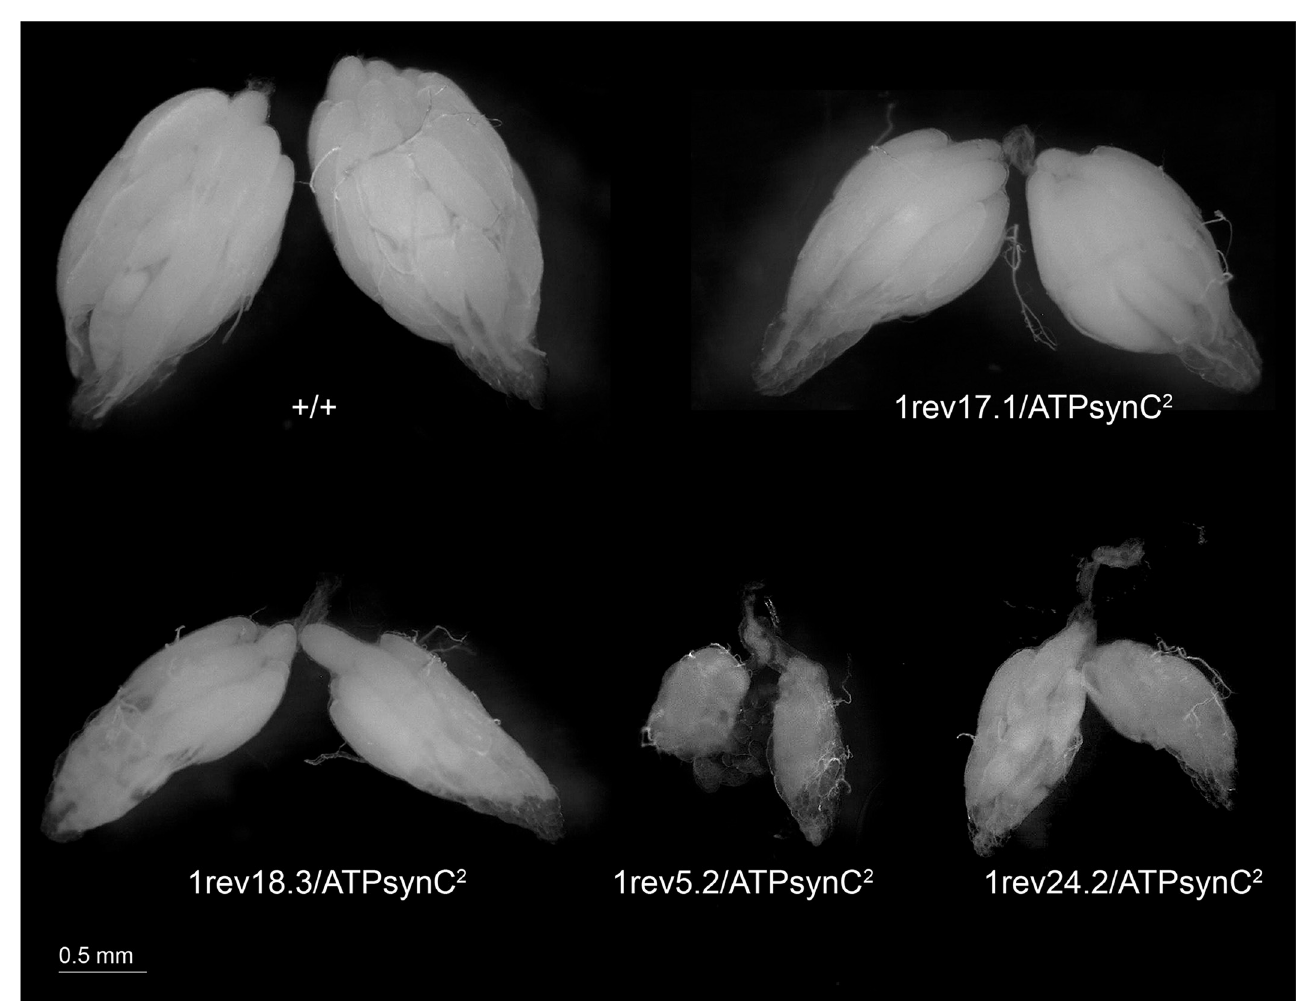
Fig 5. Aberrant gonadogenesis in females trans-heterozygotes for the ATPsynC pleiotropic mutations. Dissected ovaries from 5-days old females are compared. +/+ = Oregon-R female.